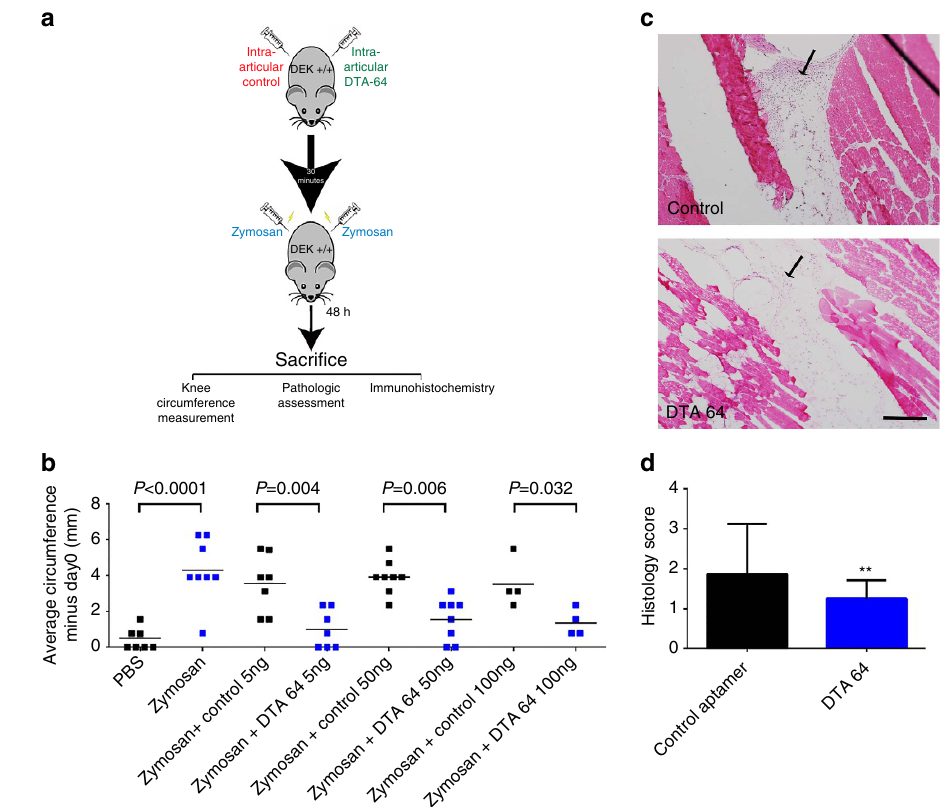
Figure 2 | Zymosan induction of joint inflammation is blocked by DEK aptamers. ( a )WT mice were injected on day 0 with 5, 50 or 100ng per knee of non-specific DNA aptamer controls or DEK-specific aptamer (DTA-64) prior to injection with PBS alone or zymosan alone as negative and positive controls, respectively. Knee circumferences were measured at the time of injection (day 0), as well as at 48h following injection. ( b ) Mean values of increased knee circumferences are shown at 48h after injection. Results shown are from 4–8 individual mice per group and from two independent experiments ( n ¼ 53 mice). Differences in the knee circumference between mice receiving control aptamers versus DTA 64 aptamer (5–100ng) were statistically significant (* P o 0.032) as determined by two-tailed, unequal variance Student’s t -test. ( c ) Representative sections from seven knees injected with 50ng control aptamer versus seven knees injected with 50ng DTA-64 stained by H&E at 48h after injection. Arrowheads indicate inflammatory cell migration into the knee joint. Magnification (cid:3) 10 (scale bar 200 m m). ( d ) Semi-quantitative scoring of blinded histological assessment from control Student’s t -test. Results are from two independent experiments (error bars, elastase antibody, when compared to neutrophils from WT mice (Fig. 4b,d; P ¼ 0.00019 as determined by two-tailed, unpaired Student’s t -test). Interestingly, DEK staining was detected only in